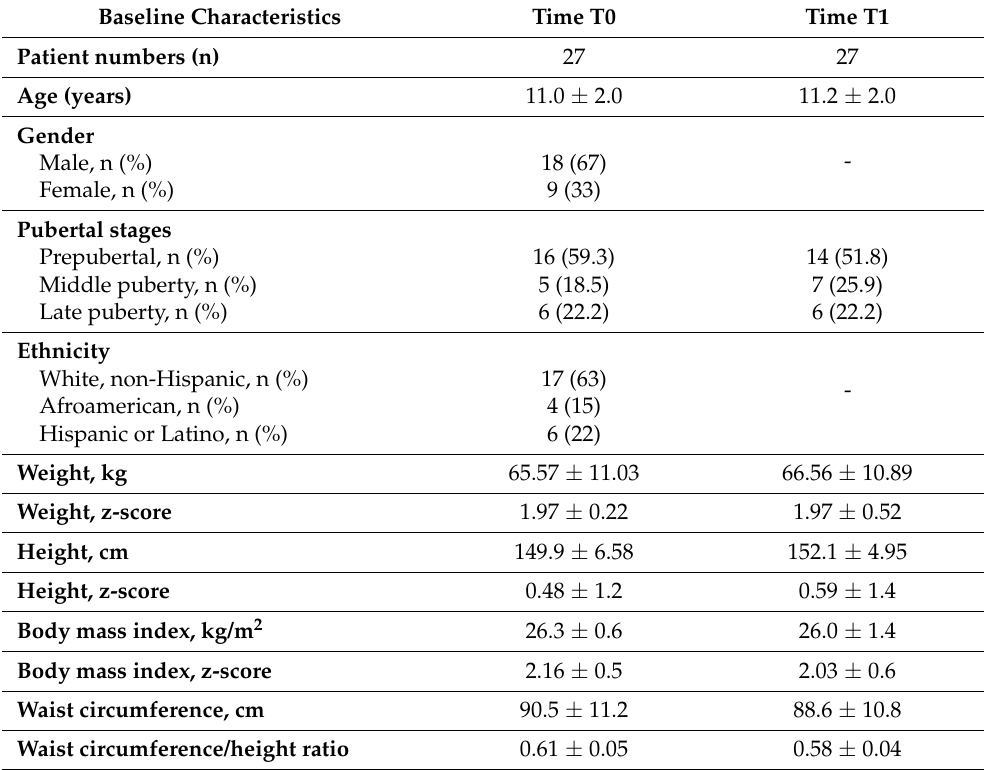
Table 1. Baseline data of the enrolled pediatric patients. Quantitative variables are expressed as the mean ( ± standard deviation, SD) and categorical variables are described as counts and percentages.